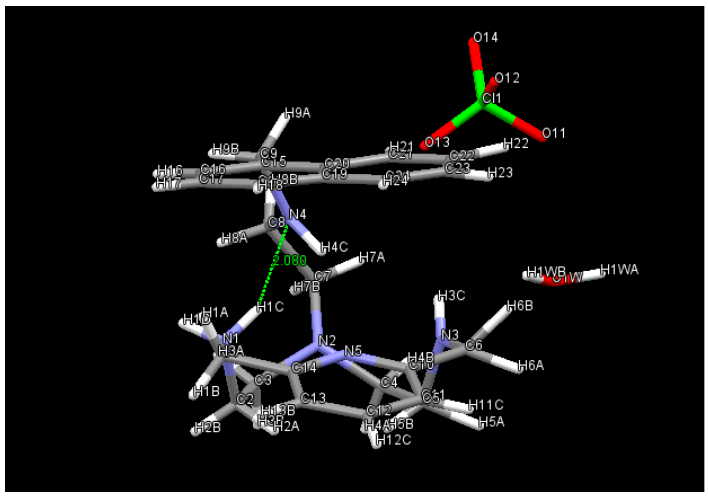
Figure 2. Distance between NH and N, which proves the presence of the H–bond in the monoprotonated A .